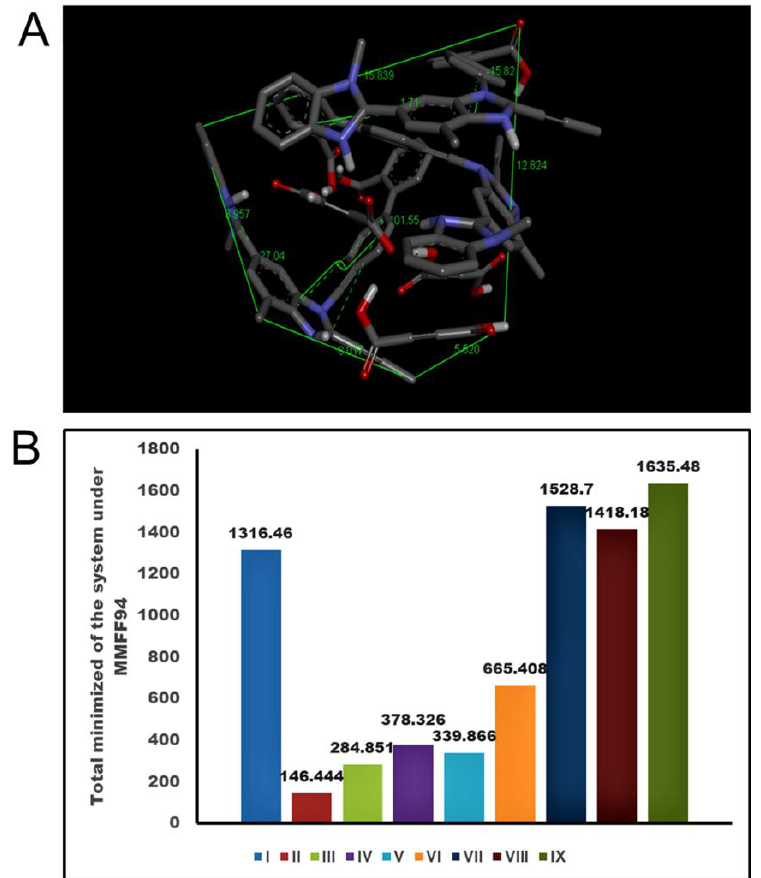
Figure 2. Spatial conformation and energy analysis of TEL-MAL-MALION complex in its most favored arrangement. ( A ). 3D space conformation of TEL:MAL:MALION = 3:1:2, ( B ). Graphical representation of system energy in various molar ratios of TEL-MAL-MALION [(I- Solitary TEL used for docking and complexation); (II-Solitary MAL); (III-Solitary MALION); (IV-TEL:MAL:MALION = 1:1:0); (V-TEL:MAL:MALION = 1:1:1); (VI-TEL:MAL:MALION = 2:1:1); (VII-TEL:MAL:MALION = 3:1:1); (VIII-TEL:MAL:MALION = 3:1:2); (IX-TEL:MAL:MALION =